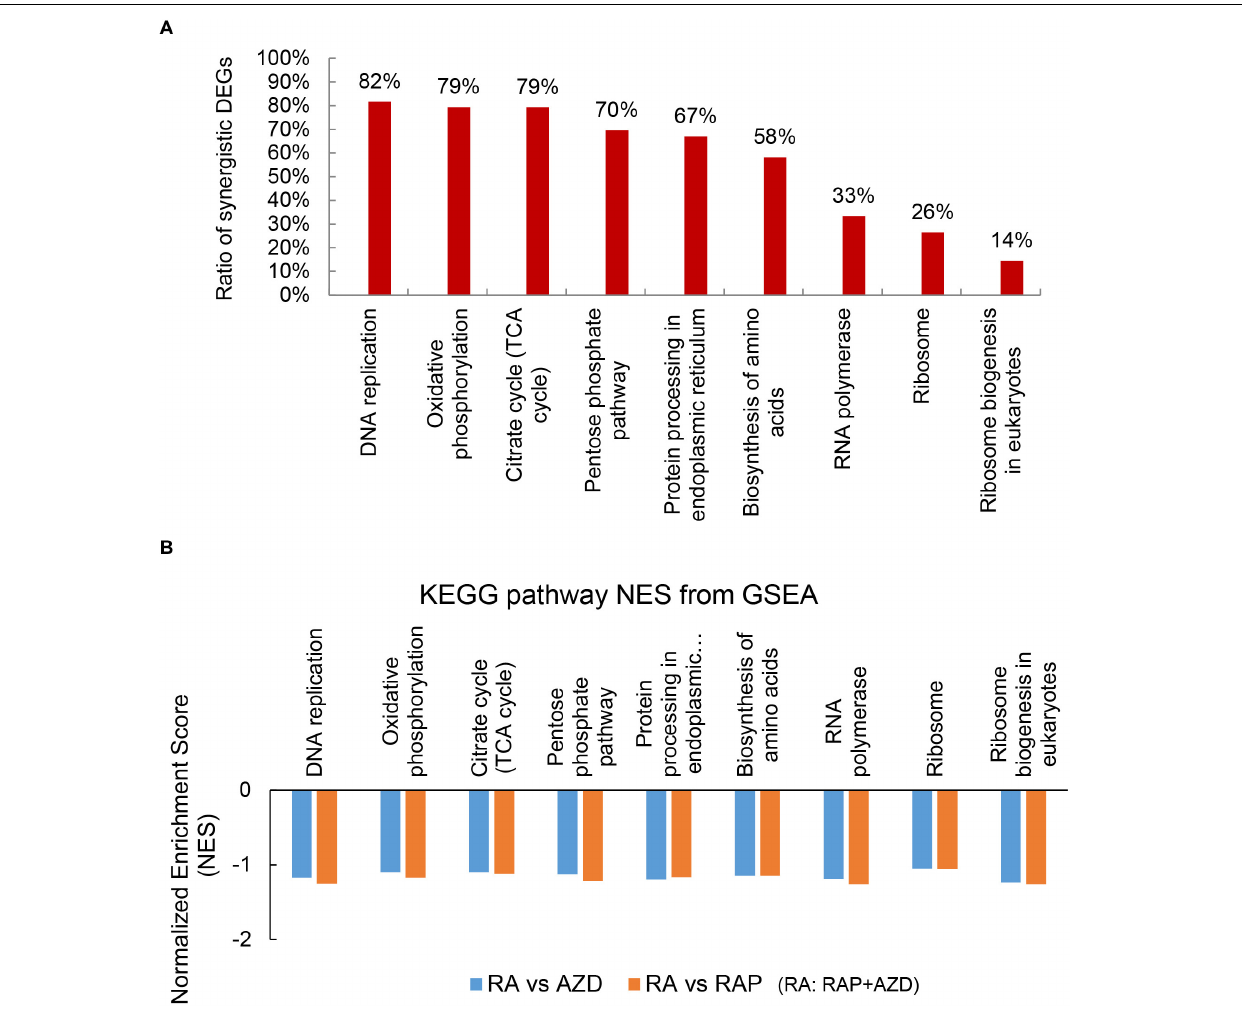
( Supplementary Figure 3 and Supplementary Table 1